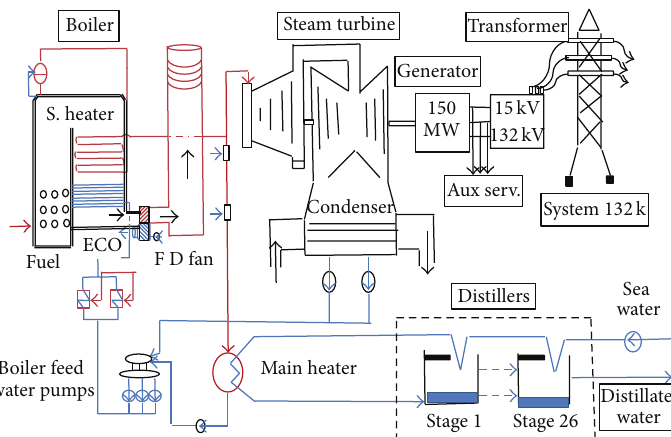
Figure 2: The elements of the units of a typical cogeneration plant in